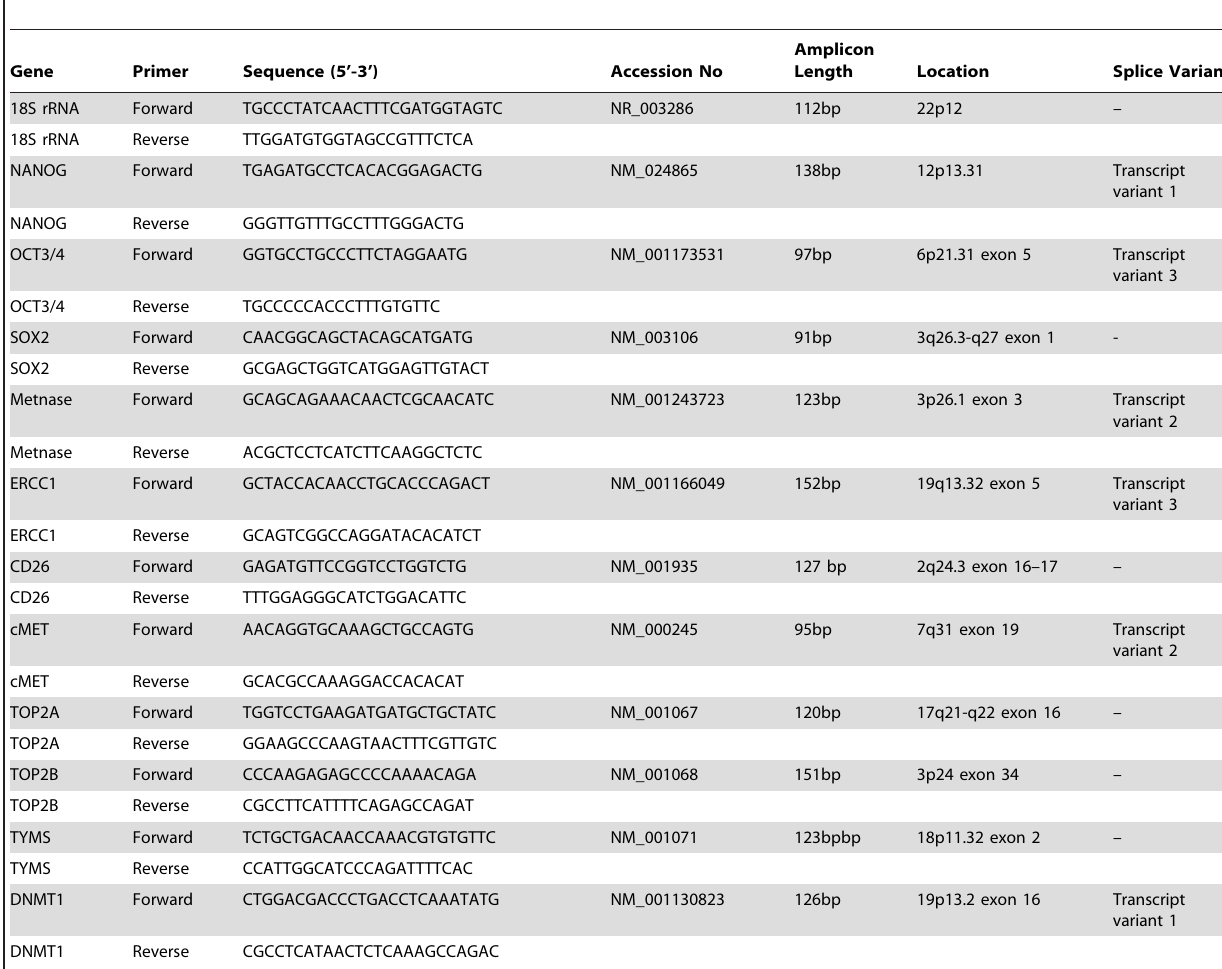
Table 1. Primer pairs that were used in